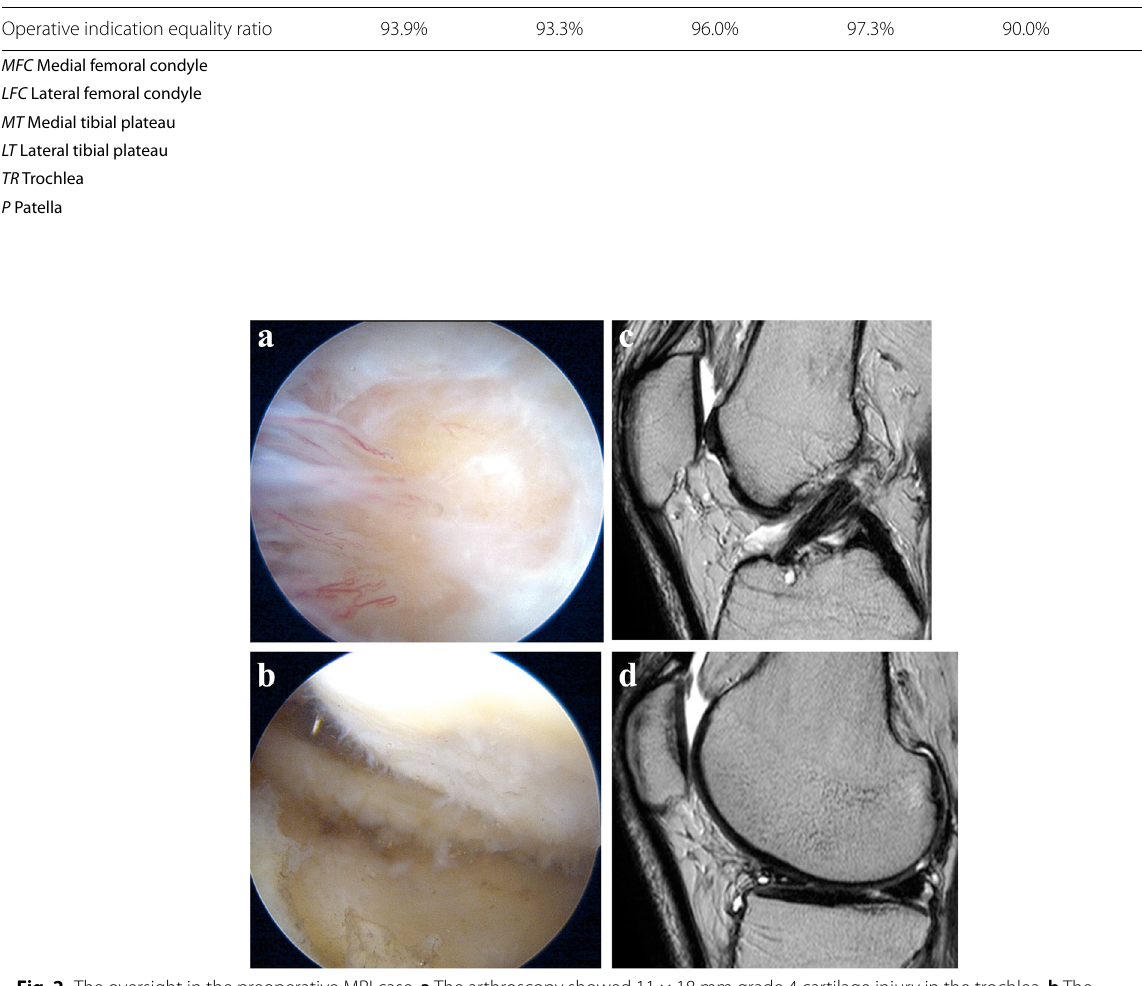
Fig. 2 The oversight in the preoperative MRI case. a The arthroscopy showed 11 18 mm grade 4 cartilage injury in the trochlea. b The × arthroscopy showed 10 10 mm grade 3 cartilage injury in the lateral femoral condyle. c His preoperative MRI showed the unevenness of articular × cartilage with associated effusions in T2-weighted sequences in the trochlea. d His preoperative MRI showed the unevenness of articular cartilage with associated effusions in T2-weighted sequences in the lateral femoral